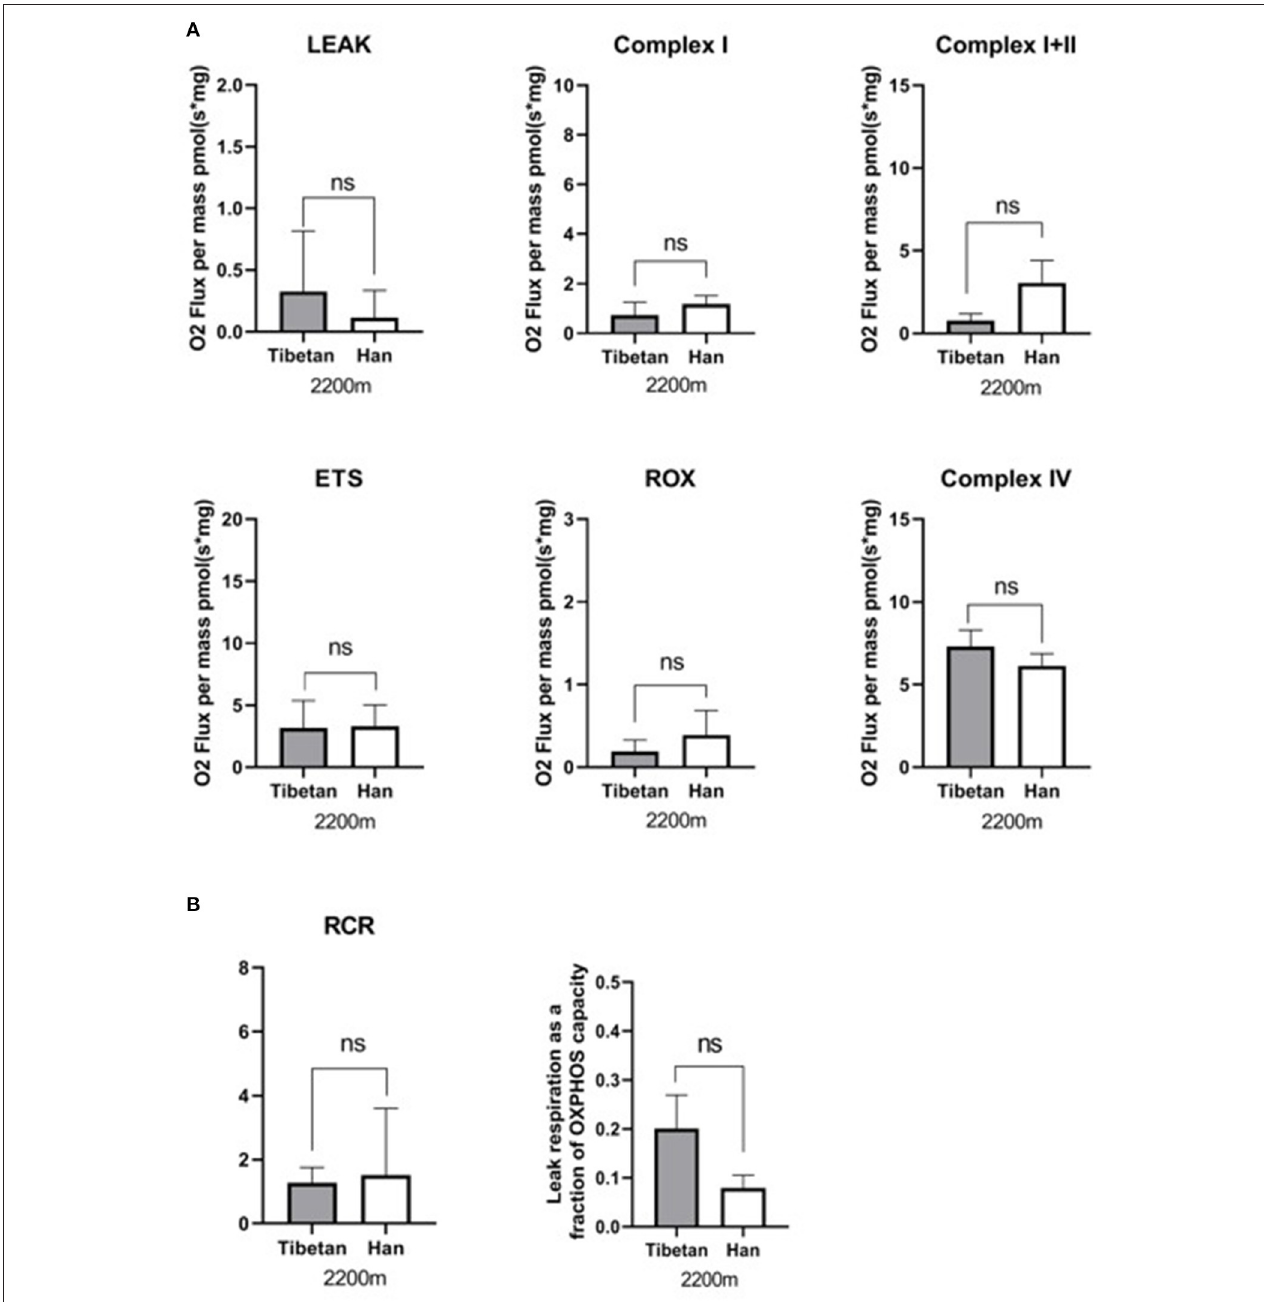
FIGURE 3 | Respiration in lower-altitude Tibetan vs. Han groups. (A) Oxidative phosphorylation (OXPHOS) with substrates for mitochondrial complexes I (CI), C I + II, and CIV; non-phosphorylating respiration (LEAK); ETS maximum capacity respiration; and non-ETS respiration (ROX) were not statistically significantly different between the lower-altitude Tibetan and Han groups. ns: p ≥ 0.05. (B) The respiratory control ration (RCR) and LEAK/ETS was not statistically significantly different between the lower-altitude Tibetan and Han groups.